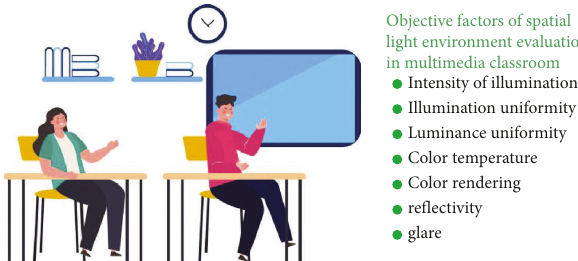
Figure 6: Composition of objective influence factors.